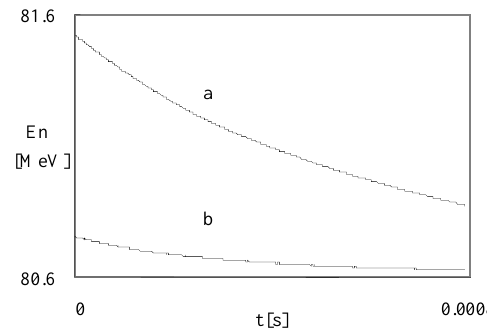
FIG. 11. (cid:115) (cid:82) (cid:121) (cid:81) (cid:100) ’s for modes from the FM passband: (cid:115) (cid:114) (cid:100) accelerating mode, (cid:115) (cid:101) (cid:100) other modes.